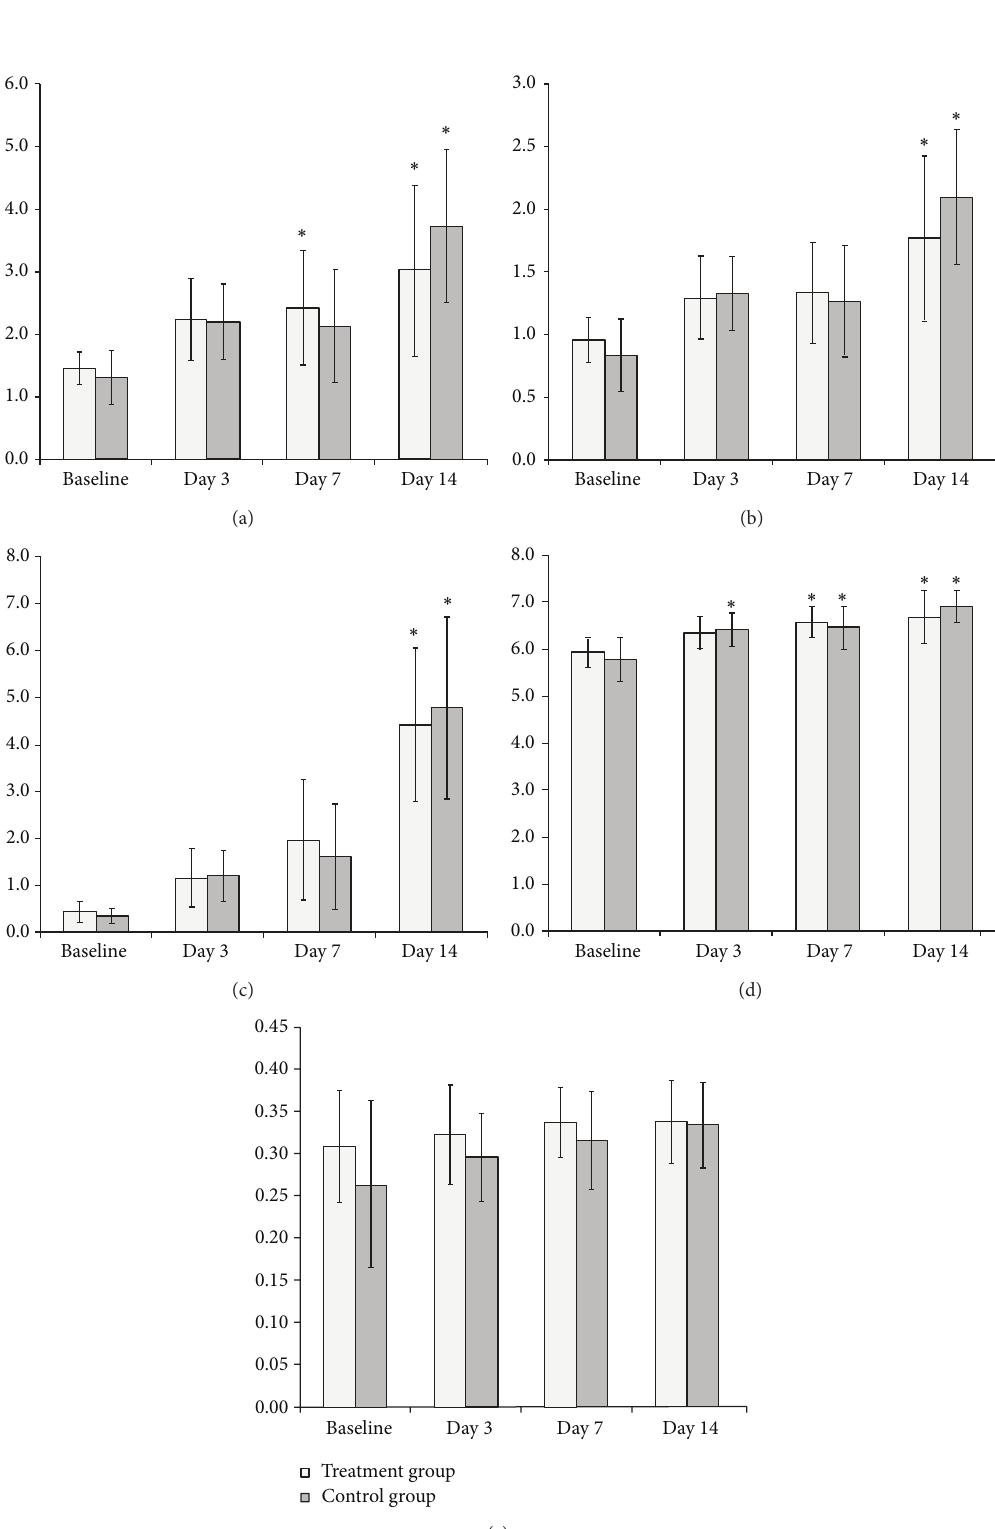
Figure 3: Averaged (a) SUVmax, (b) SUVmean, (c) TLG, (d) entropy, and (e) homogeneity before and at different time points after bevacizumab therapy. SUVmax, SUVmean, TLG, and entropy showed an increasing trend in both groups. ∗ is significant change compared to the baseline, SUV is standardized uptake value, TLG is total lesion glycolysis, and FMR is flow-metabolic